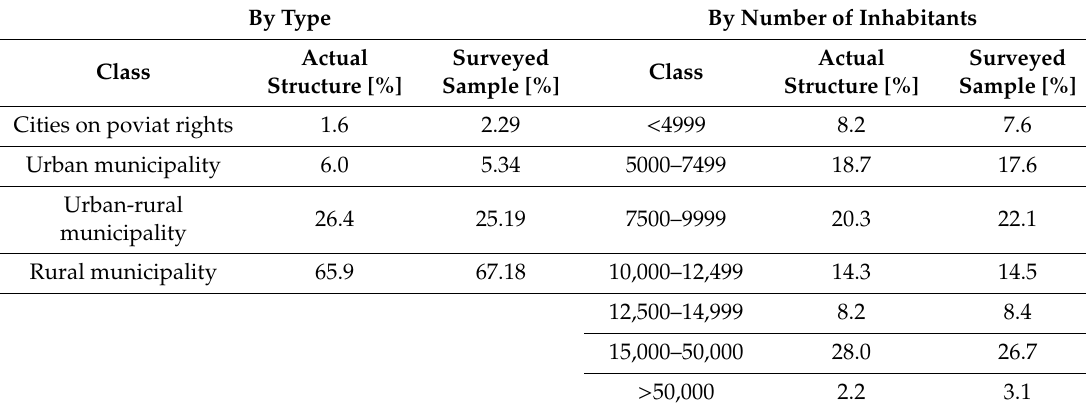
Table 2. Actual structure of municipalities in Malopolska Voivodeship and the structure of the surveyed